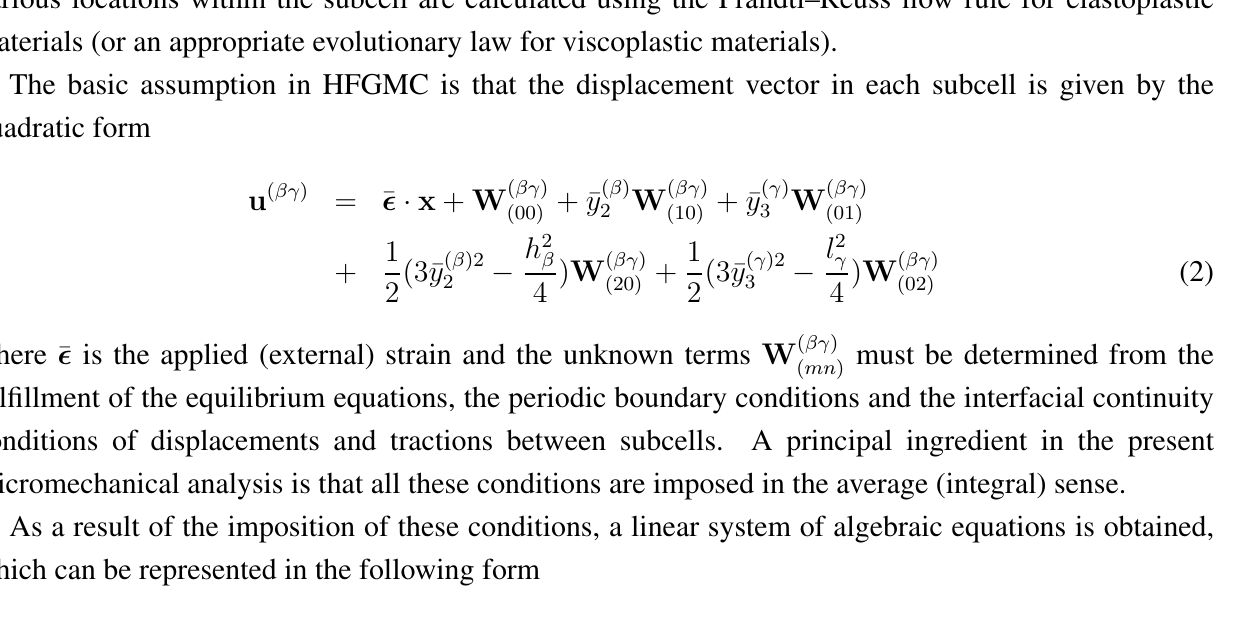
Figure 1. A multiphase composite with a periodic microstructure in the global system − x x , characterized by a repeating unit cell (highlighted). The repeating unit cell is 2 3 given with respect to the local coordinate system y